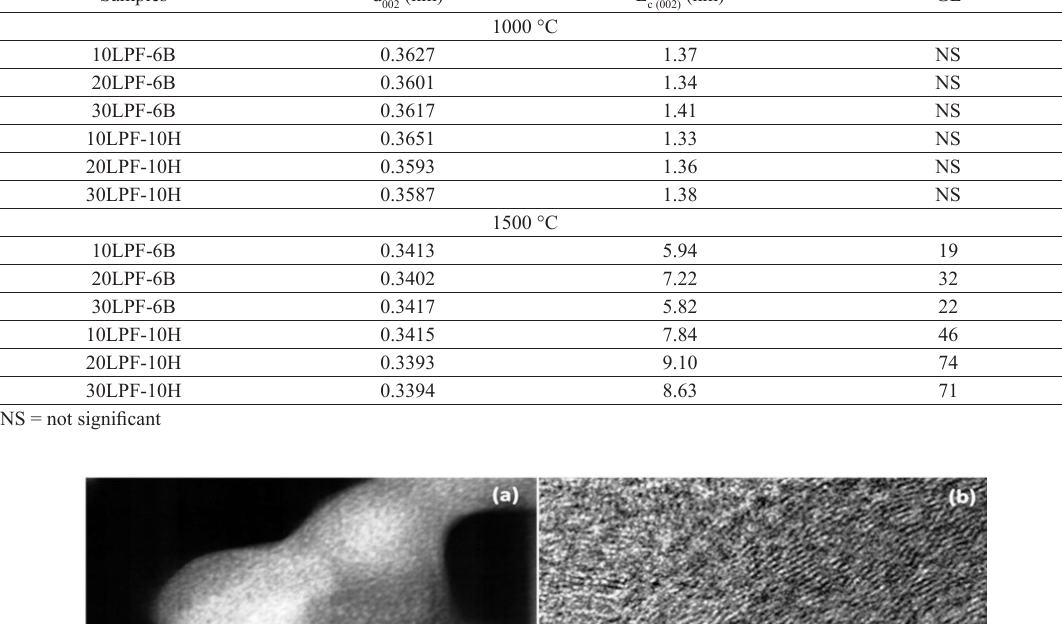
Table 5. Interlayer spacing, and crystallite height values of carbon derived from plain LPF resins containing boron compounds after firing at 1000°C or 1500°C/5h. Samples